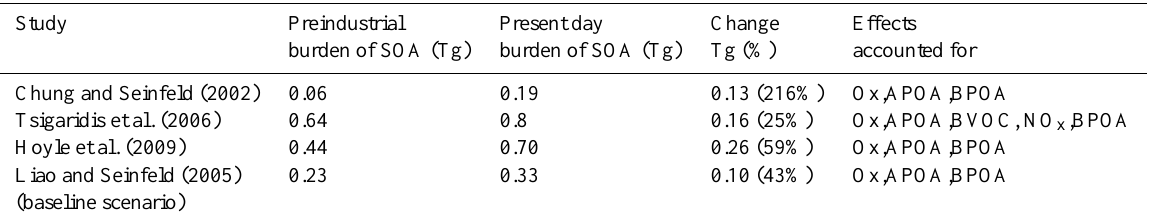
Table 3. The pre-industrial and present day burdens of SOA calculated in several modelling studies. The abbreviations in the last column are as follows: Ox – change in atmospheric oxidants, APOA – changes in anthropogenic POA, BPOA – changes in biogenic POA, NO x – NO x effect on SOA yields, BVOC-changed BVOC emissions since pre-industrial period. For a full description of the models, see the individual papers.